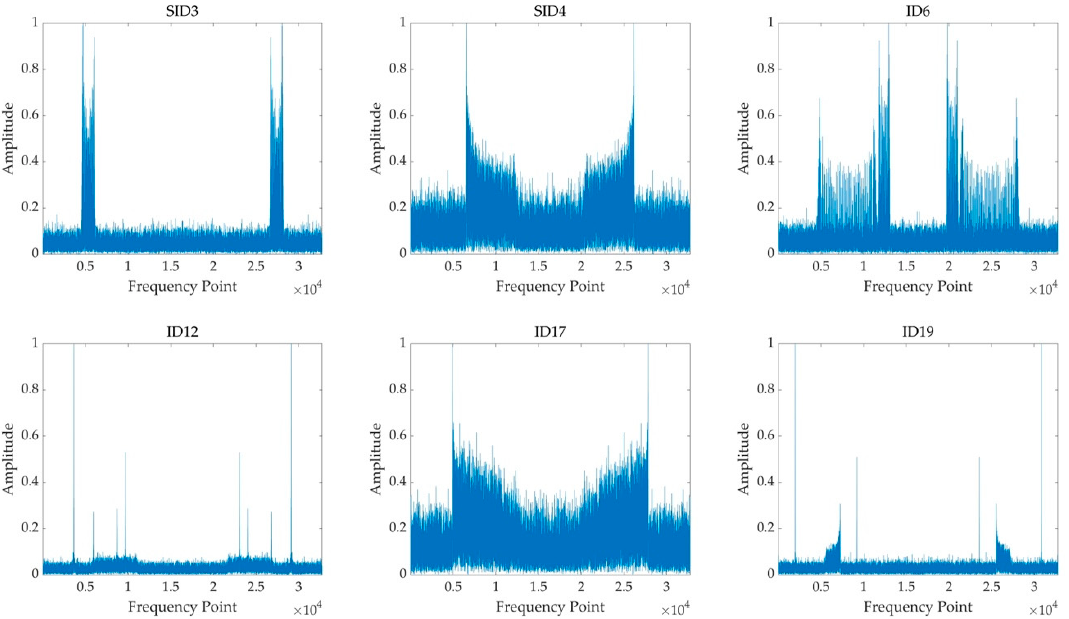
Figure 5. The preprocessed result of six modulation samples in SID3, SID4, ID6, ID12, ID17 and ID19 when SNR is 0 dB.